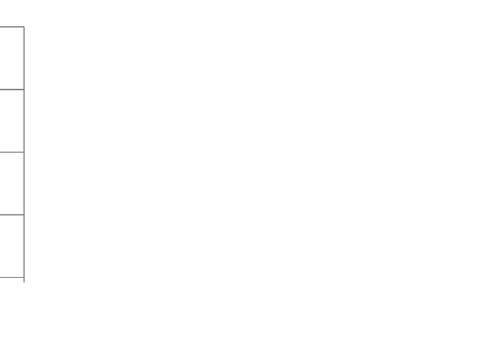
Figure 6. Relative intensity of MF in the cell wall of the cured samples as shown in Fig. 5. The bars represent standard deviation from five replicates. Different letters indicate significant differences ( P <